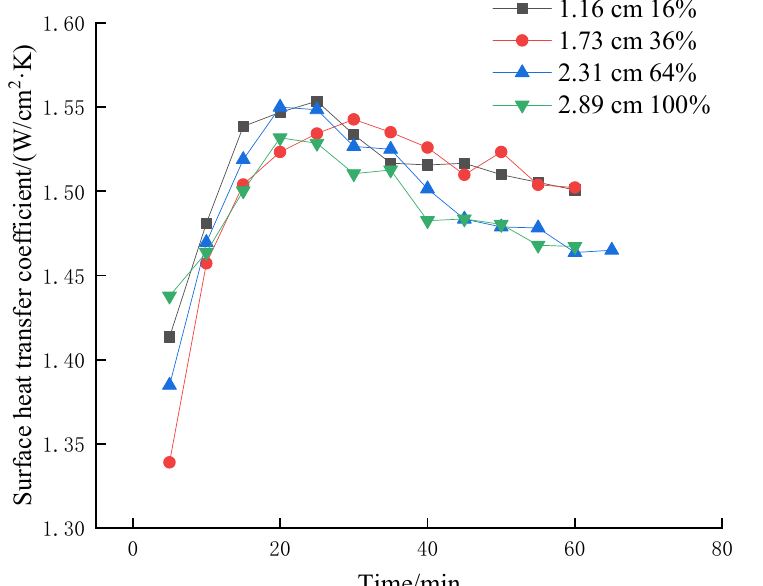
Figure 15. The influence of the coverage rate of changing height at 100 W/cm 2 on the transient surface heat transfer coefficient.